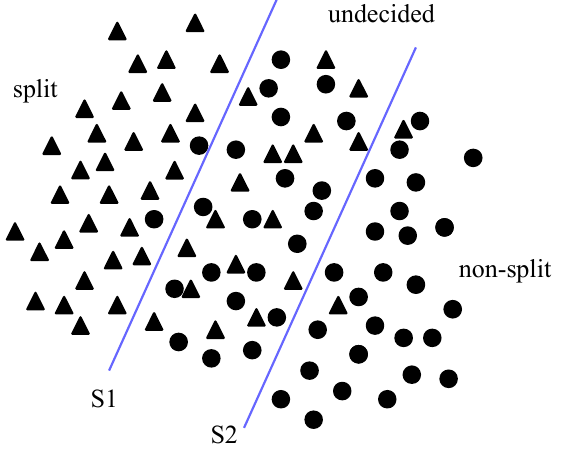
Figure 4. An illustration of two SVM hyperplanes that are created using Weighted SVMs using noisy sample data. The hyperplane S1 corresponds to a case where a larger weight is applied to “split” samples. Similar, hyperplane S2 represent a case where larger weights are applied to “non-split” samples of the training